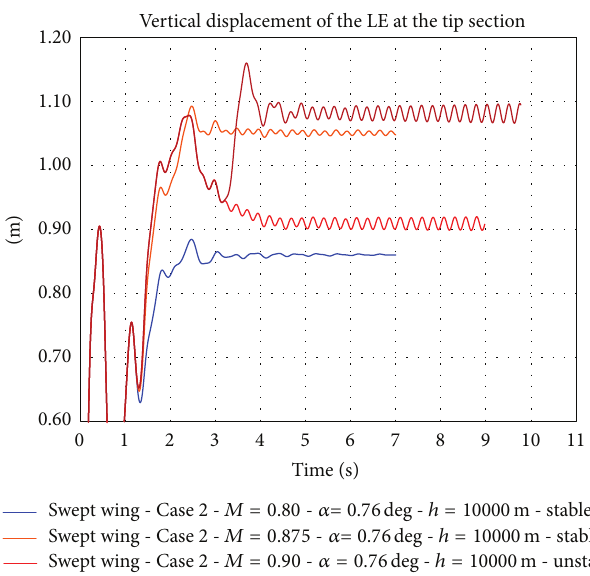
Figure 13: Results of the FSI analyses of the swept wing model (Case 2 , cruise altitude).